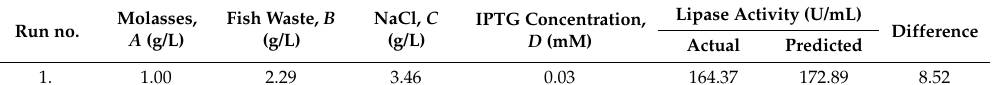
Table 6. Optimum Formulation for T1 Lipase Production.